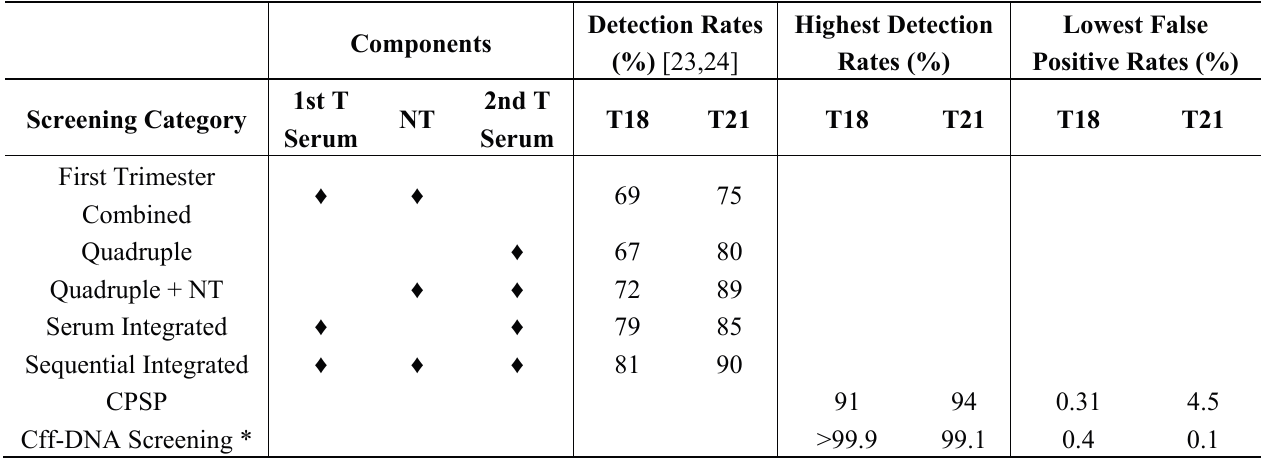
Diamond indicates elements included in the screening category: 1st Trimester serum (1st T serum), nuchal translucency (NT), 2nd trimester serum (2nd T serum). California Prenatal Screening Program (CPSP) and cell-free fetal (cff). * Sequenom’s quoted highest detection rates for cff-DNA screening were utilized for